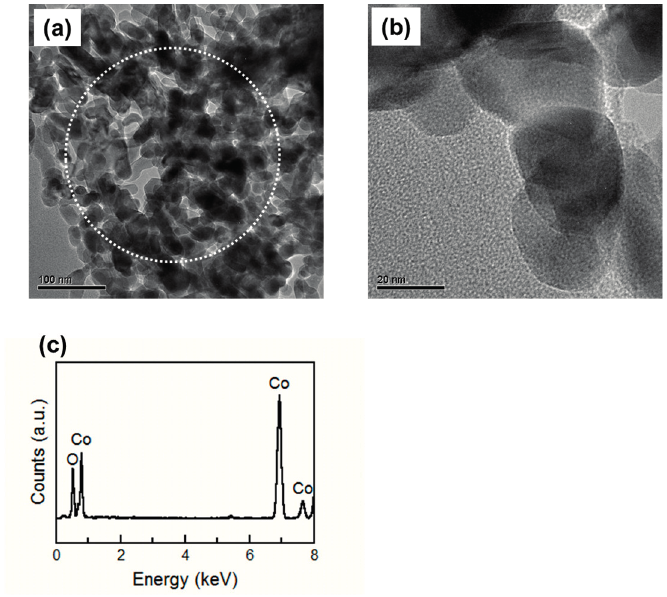
Figure 5. ( a , b ) TEM images of the Co 3 O 4 powder; ( c ) EDX analysis result of the area inside the circle in the ( a ) image. The powder is baked at 400 °C for 2 h.